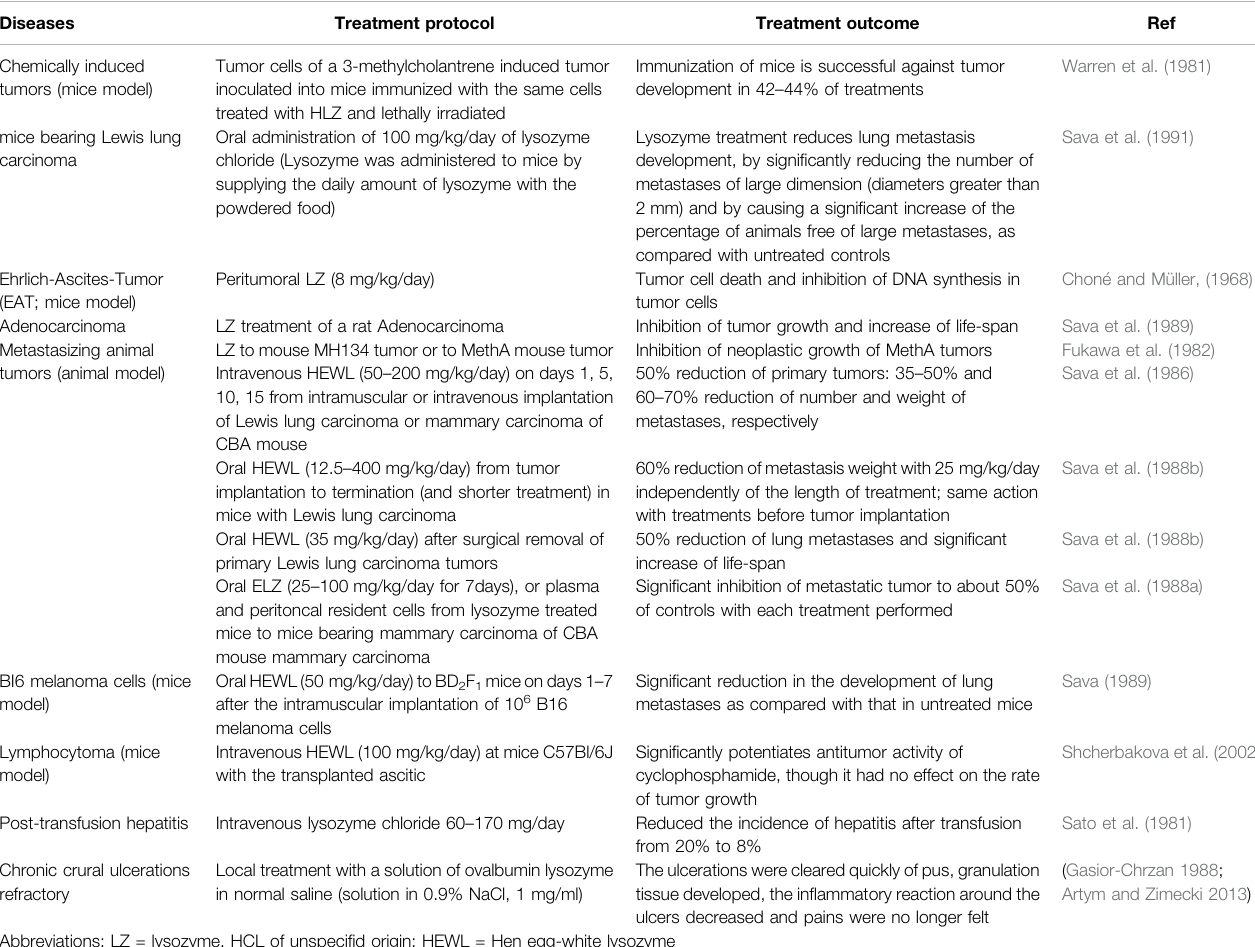
TABLE 3 | The delivery, dose and ef fi cacy of lysozyme in